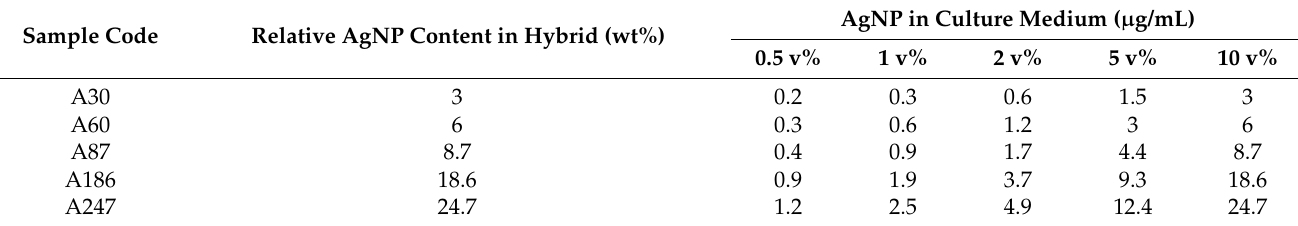
Figure 5. Assessment of toxicity of biocides on J774A1. Dose-dependent survival curve for cells treated for 24 h with various concentrations of hybrids. Table 4. Concentrations of AgNP for various hybrid volume fractions analyzed for toxicity on J774A1. Sample